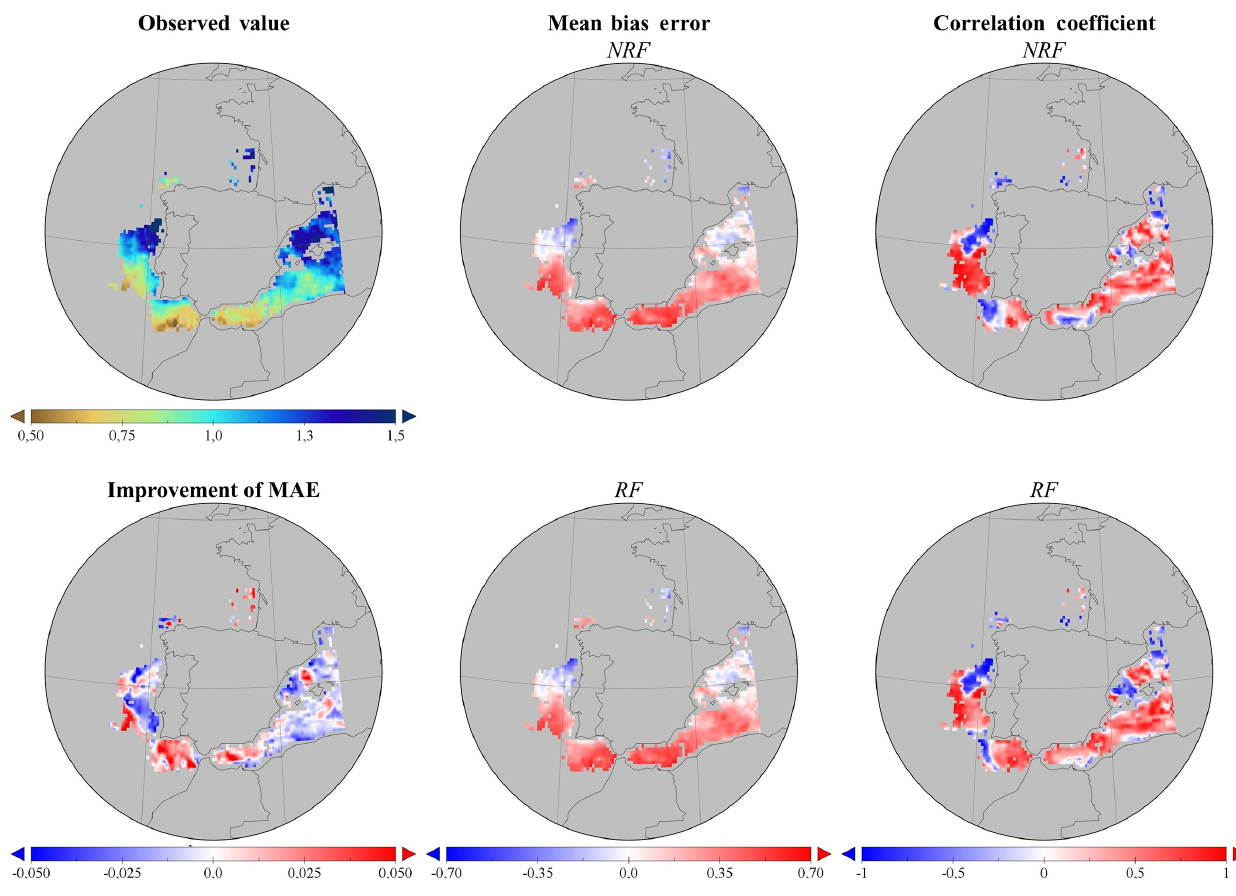
Figure 7. As Fig. 6 for the fire episode (temporal mean from 25 July to 7 August).